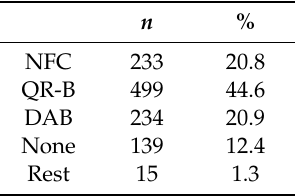
Table 7. The consumer’s choice on the three proposed technologies (Near Field Communication (NFC), Dispositivo Antimanomissione per Bottiglie (DAB), and Quick Response Blockchain (QR-B)). “Rest” indicates people that do not consume extra virgin olive oil